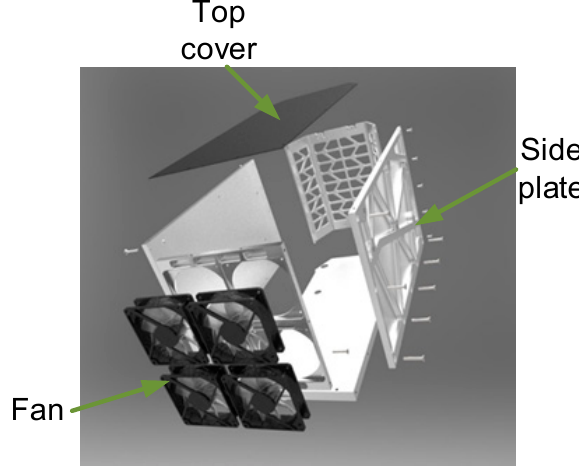
Figure 11. Battery-pack container.